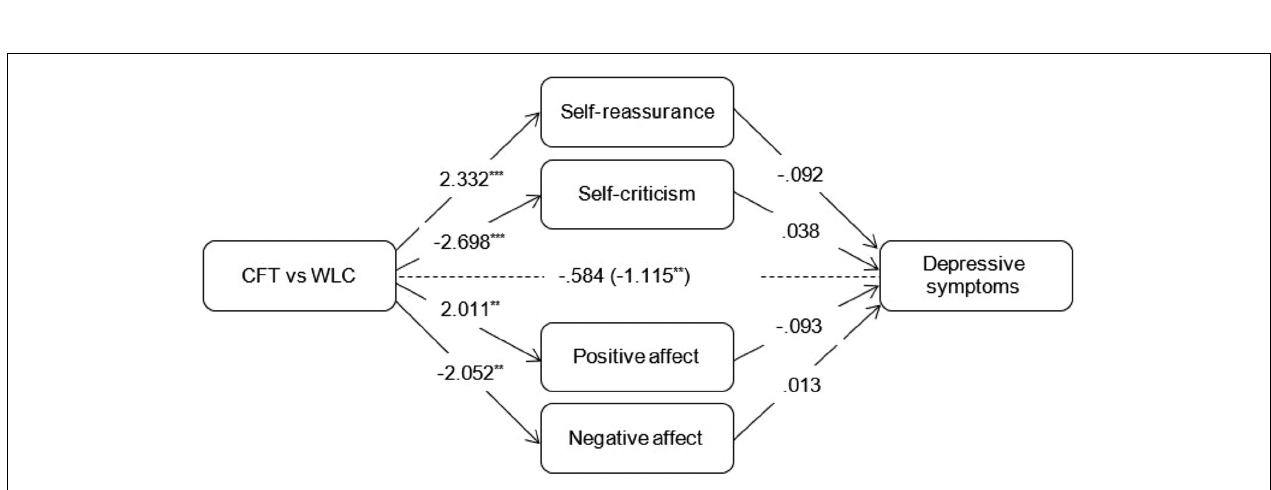
FIGURE 2 | Outcomes of multiple mediation models assessing indirect effects of mediators on changes in well-being compared to the waitlist control condition. Total effect (c-path) is given in parentheses. ∗ p < 0.05. ∗∗ p < 0.01. ∗∗ p < 0.001.